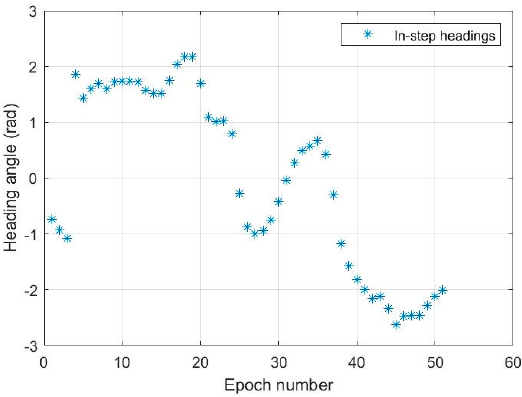
Figure 8. In − step headings from horizontal linear accelerations.